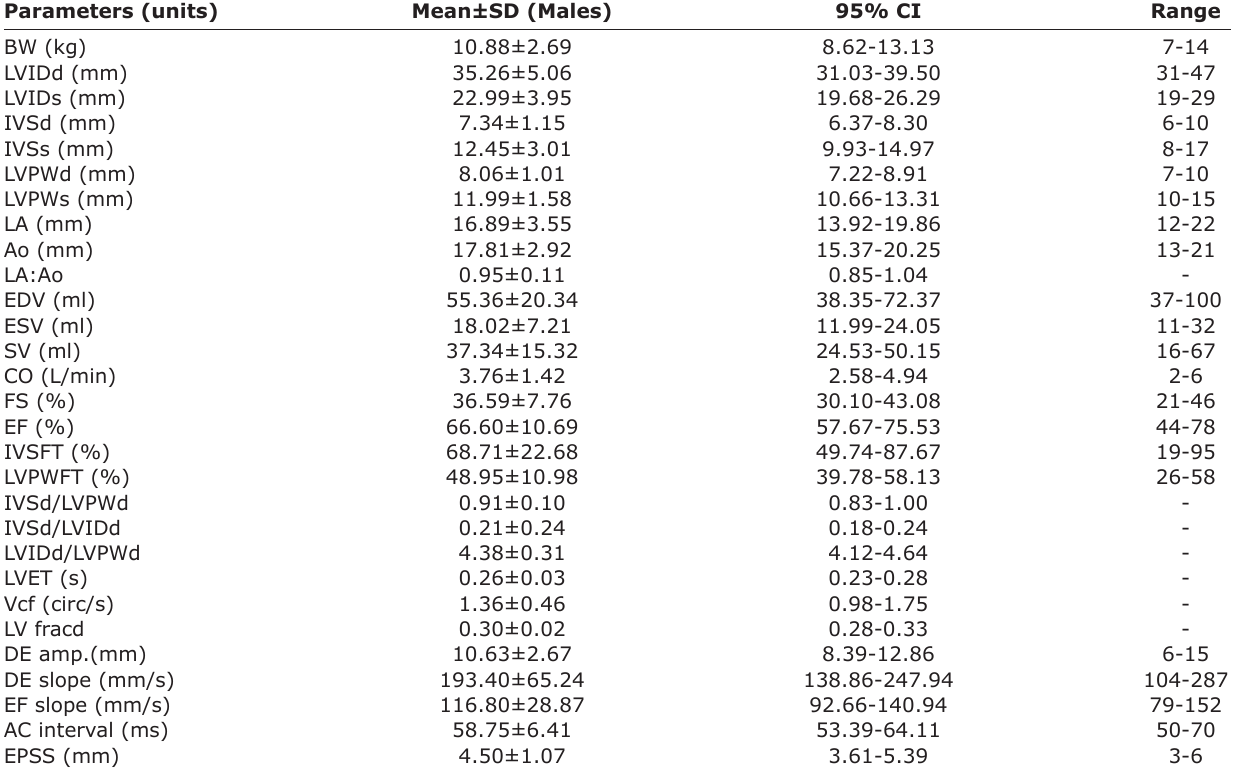
Table-2: M-mode echocardiographic measurements in male Indian Spitz dogs. Parameters